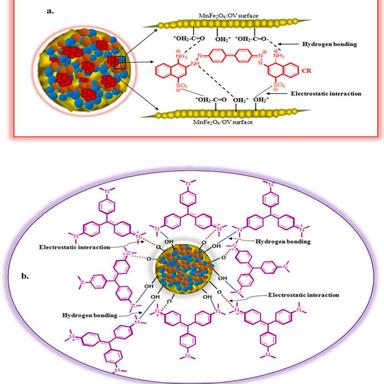
(a) Proposed mechanism for CR (b) adsorption onto MnFe2O4/OV.